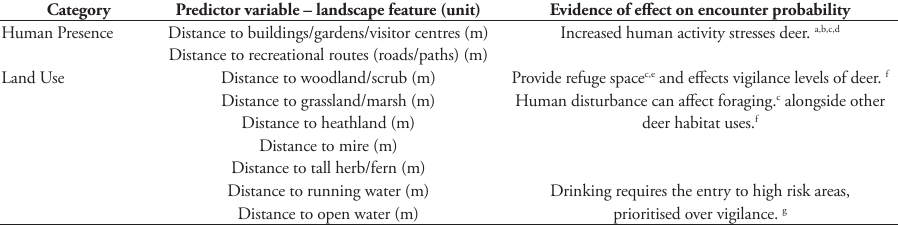
table 1. Predictor variables used in the study. Showing evidence of importance in relation to human- ungulate encounters.